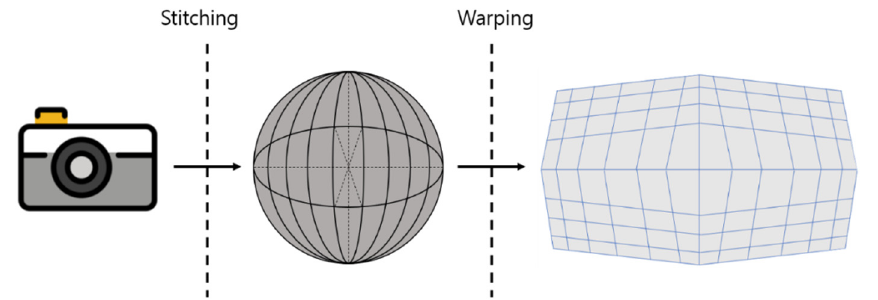
Figure 2. Stitching and warping for 360-degree videos.